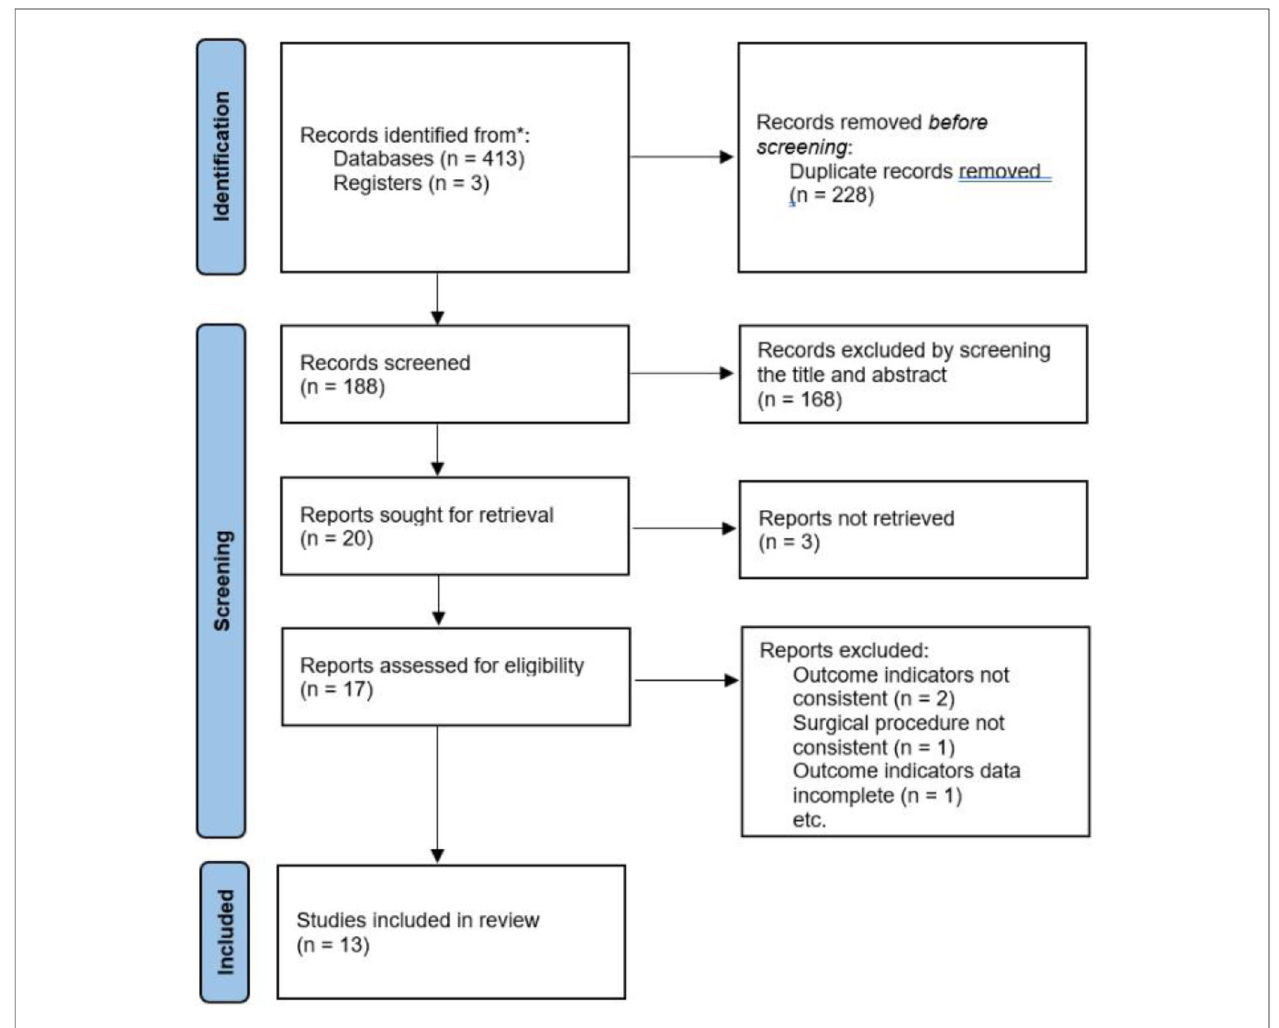
FIGURE 4 | Literature screening process.